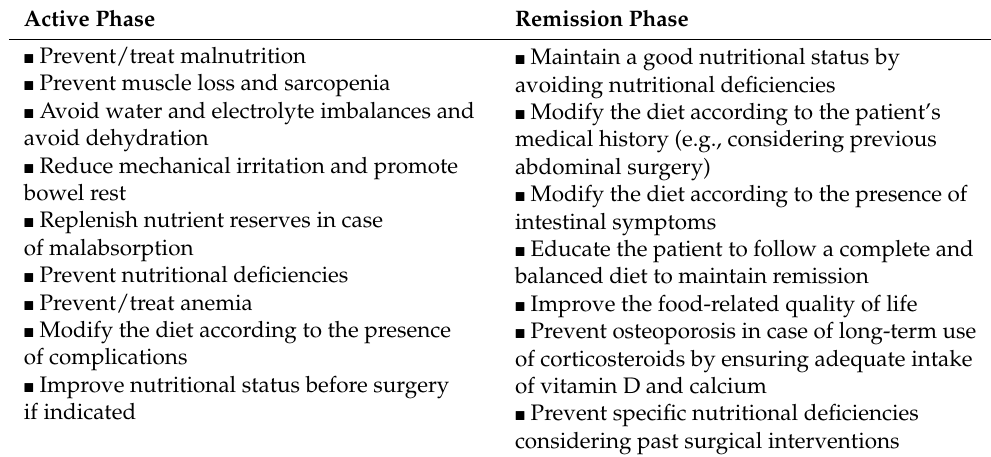
Table 1. Aims of nutritional intervention according to disease’s activity. Active